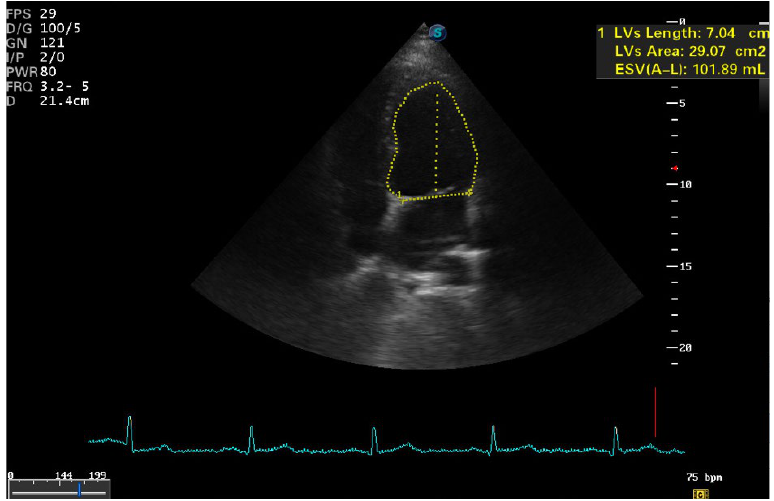
Figure 11. Case 3—TTE Left ventricle tele-systolic volume evaluation (yellow dotted line) . The 24 h ECG Holter monitoring revealed: The average heart rate was 101 bpm. The minimum heart rate was 64 bpm. The maximum heart rate was 196 bpm. Ventricular results: There were a total of 734 (0.49%) beats—429 (58.45%) single beats, 85 (23.16%) couplets, 25 (10.22%) runs, 11 (8.17%) tachycardiac events. Fastest tachycardia episode: 10 beats, 219 bpm. Longest tachycardia episode: 11 beats, 211 bpm. Supraventricular results: There were a total of 6636 (4.46%) beats—936 (14.1%) single beats, 379 (11.42%) couplets, 203 (9.18%) runs, and 349 (65.28%) tachycardiac events. Fastest tachycardia episode: 6 beats, 240 bpm. Longest tachycardia episode: 771 beats, 166 bpm. Rhythm results: Atrial fibrillation was detected in 0.20% (0 h 03 min) of the total monitoring time. Atrial flutter was detected in 0.46% (0 h 06 min) of the entire monitoring time (Figure 12). Treatment was initiated with ibuprofen 1800 mg/day, colchicine 0.5 mg/day for 4 days, then 1 mg/day, amiodarone 200 mg/day, apixaban 2 × 5 mg/day, and empagliflozin 10 mg/day. The evaluations at one week and at two weeks show a minimal echocardiographic improvement (by decreasing the amount of pericardial fluid) and by the disappearance of the patient’ s symptoms. Complete resorption of pericardial fluid was achieved one month after the first presentation. After complete resorpt ion, withdrawal from the ibuprofen treatment began by decreasing the administered dose by 300 mg/day every 3 days. The rest of the treatment remained unchanged. On a 3-month follow-up, the patient still had complaints of persisting moderate fatigue as well as of non- specific chest pain . ECG Holter monitoring was repeated and was found to be normal. Transthoracic echocardiography showed no improvement compared to the previous evaluation. Colchicine was discontinued, while the rest of the prescription remained unchanged. At the 6-month evaluation visit, the patient still presented with complaints of fatigue and non- specific chest pain but mild in nature, compared to the previous evaluation . ECG Holter monitoring did not identify arrhythmic or ischemic phenomena, and TTE did not show any improvement. It was decided to stop the amiodarone treatment. Even at 1 year after the first presentation, the patient still reported fatigue and non - specific chest pain with the same echocardiographic changes as before and ECG Holter monitoring within normal limits.